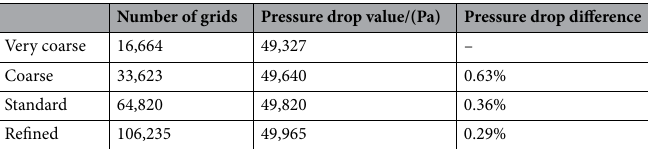
Table 2. Grid independence test.